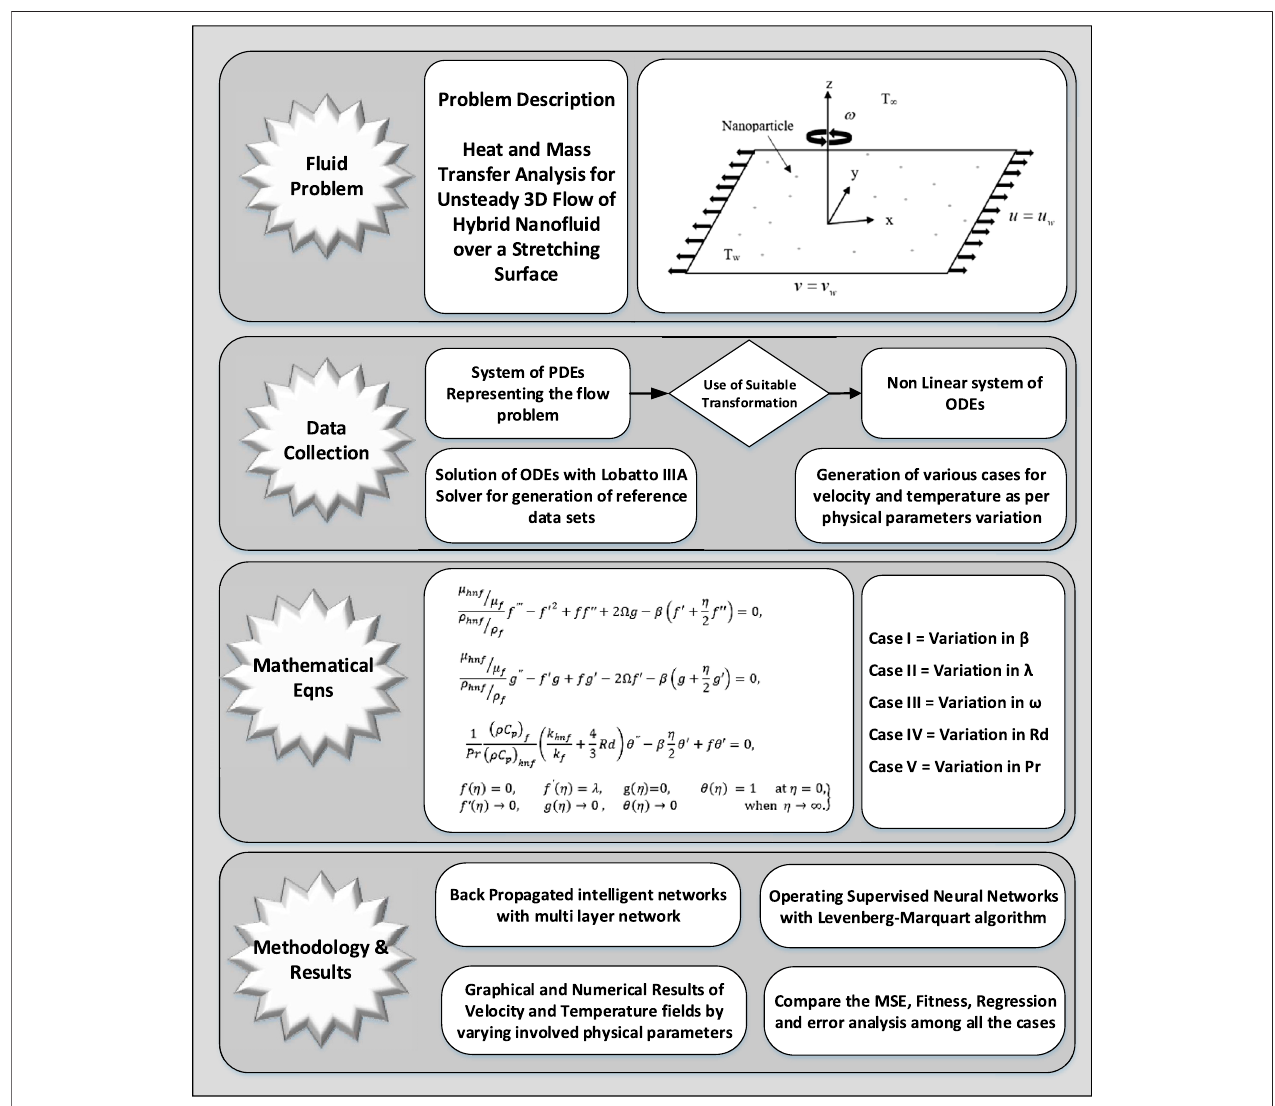
FIGURE 2 | Working fl ow